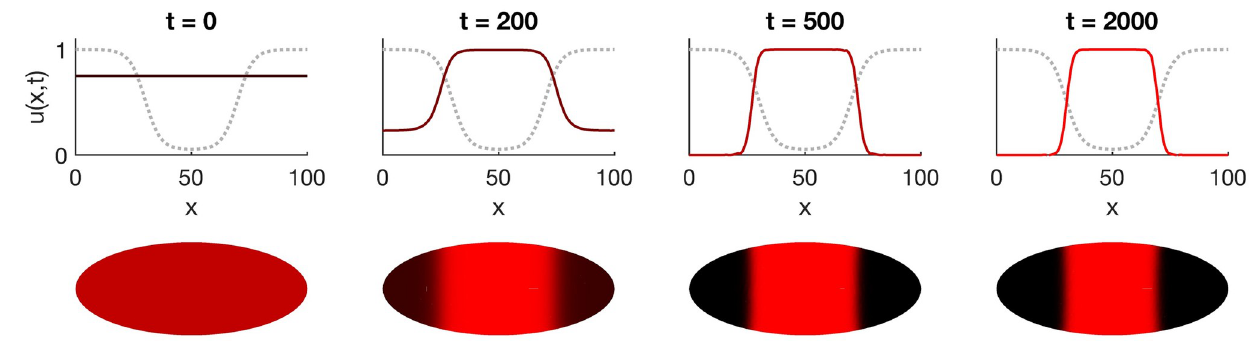
Fig 6. Fronts may localize at multiple points in a domain, resulting in more complicated patterns. Simulations were performed on the 1D model in S2 Appendix with a = 0.1, D = 0.1 on a 2D reaction domain (bottom) in which the bifurcation parameter α ( x ) varies only along the horizontal axis (gray dashed line). Top, horizontal cross-sections through the midline show that two opposing fronts appear and propagate toward the nearest localization point, resulting in refinement of a stripe pattern from either direction over time.